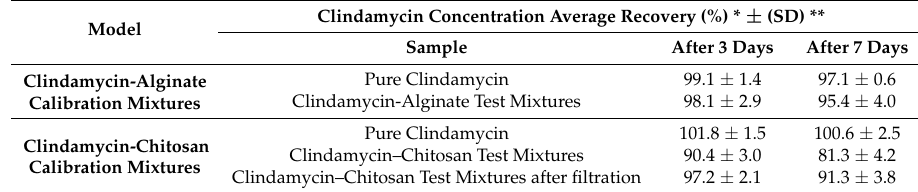
Table 2. Recovery studies for clindamycin in (1:1) drug–polymer test mixtures.